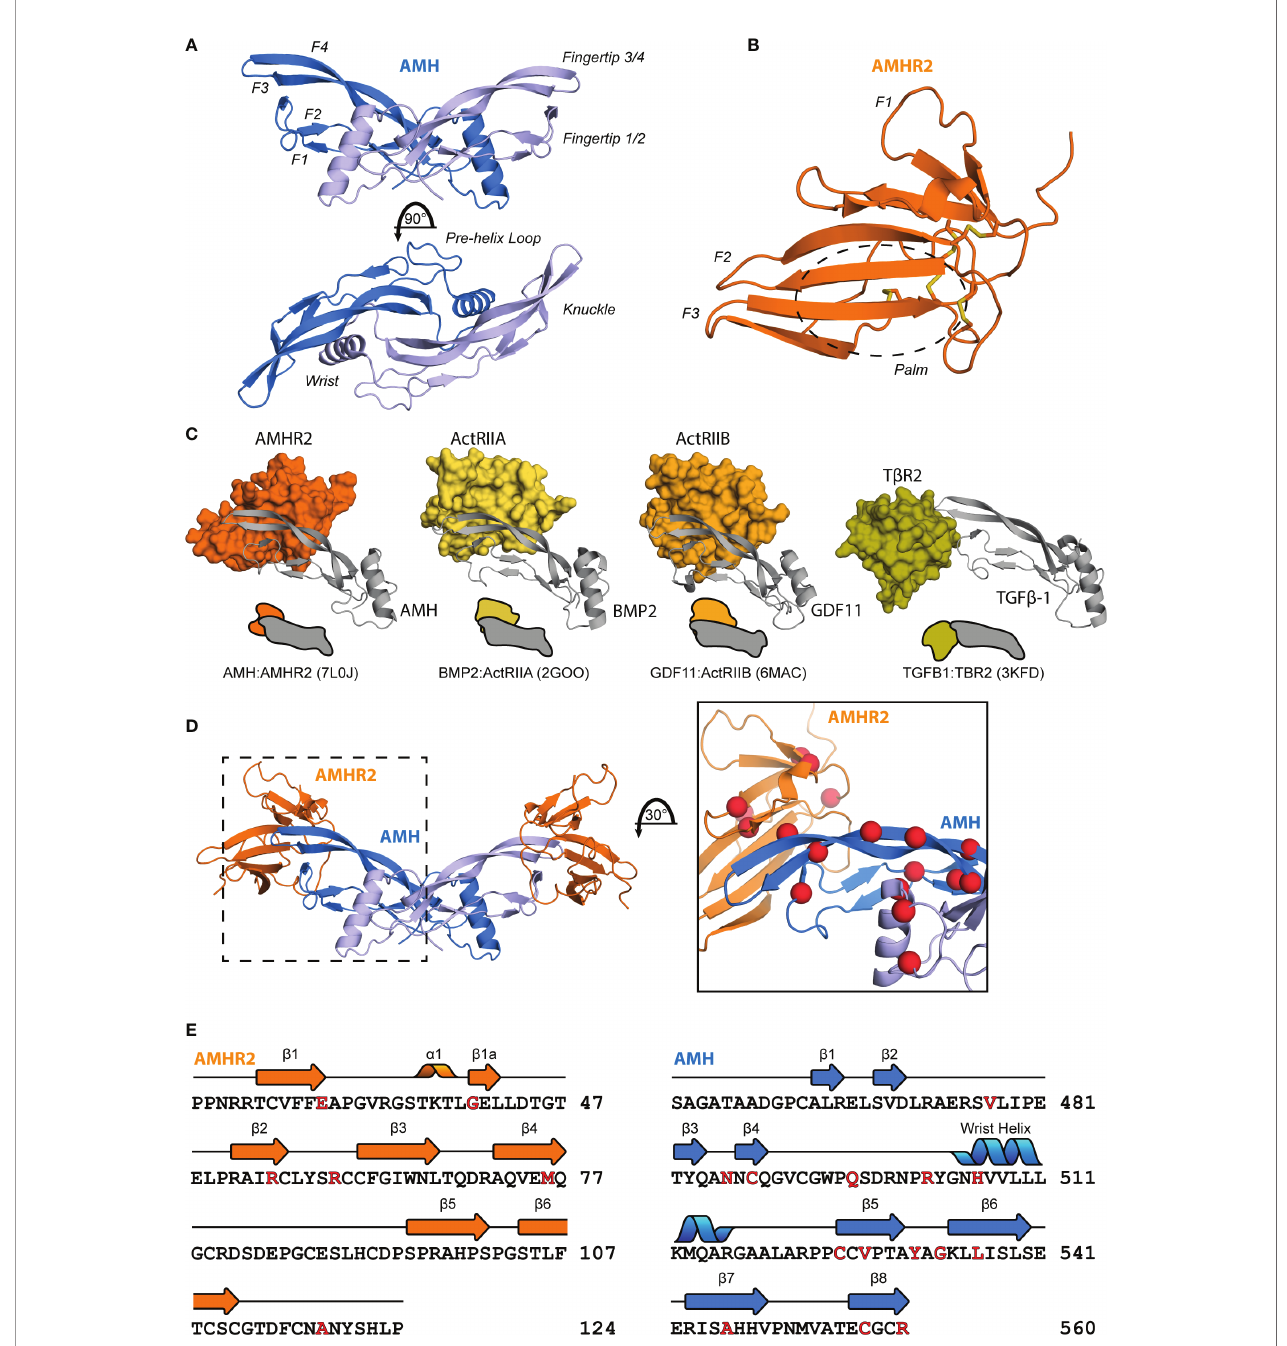
FIGURE 2 | Structural features of AMH and AMHR2. Diagram of the structure of mature AMH (A) and AMHR2 ECD (B) . (C) Comparison of the binding modes of each ligand class to a type II receptor. (D) Mapping of PMDS mutations (83), indicated by red spheres, to the binary complex. (E) Sequence of AMH and AMHR2 annotated with secondary structure features and highlighted in red with the above PMDS